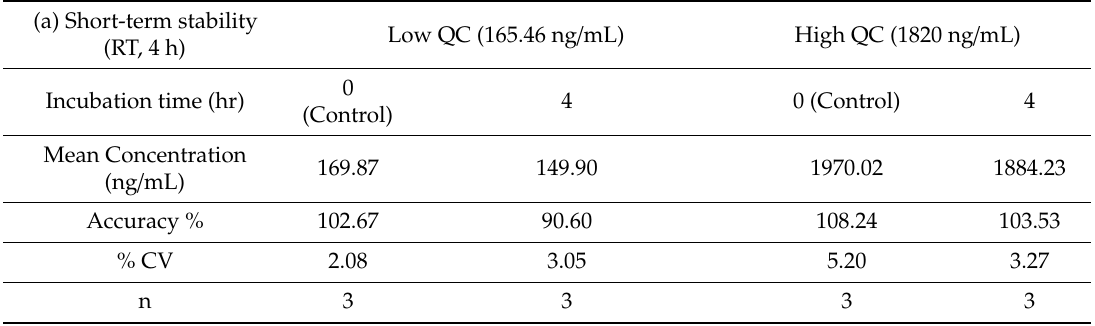
Table 5. Stability assessments of MMAF (monomethyl auristatin F) in rat plasma (a) Short-term